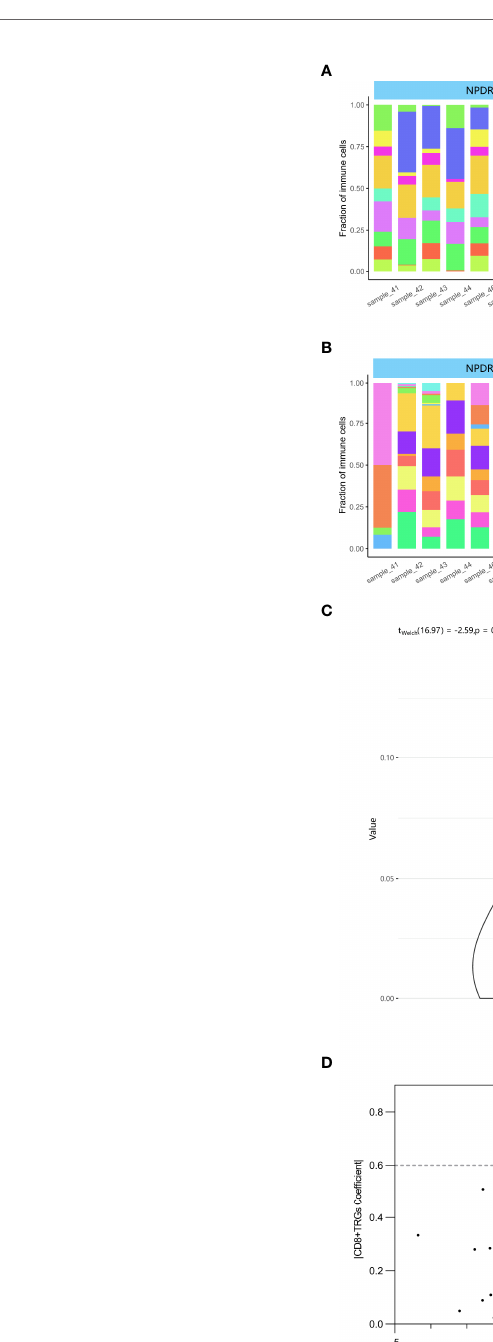
Frontiers in Endocrinology |